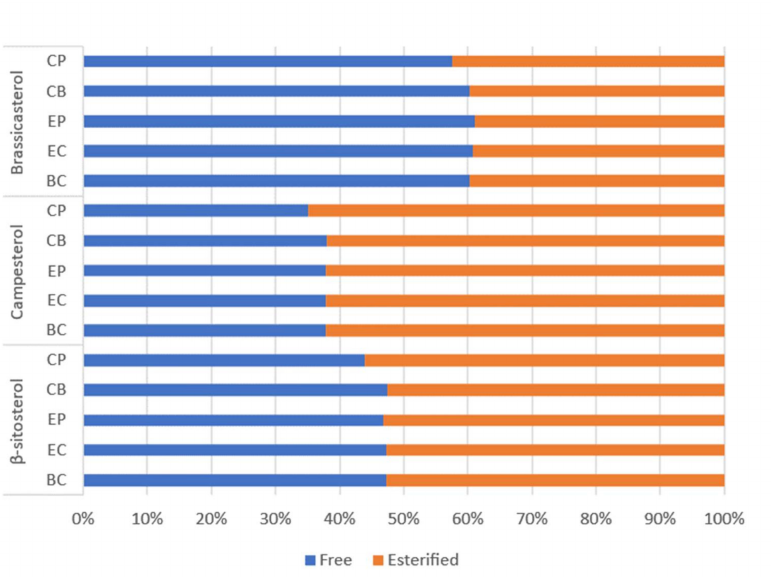
Figure 3. Average proportions of free (blue) and esterified (orange) phytosterols in canola seeds and crude oil from each process. Each bar represents the percentage (%); derived by the average of seed and crude oil concentrations across batches one and two and divided by total phytosterol concentration for the respective phytosterol homologue (esterified +